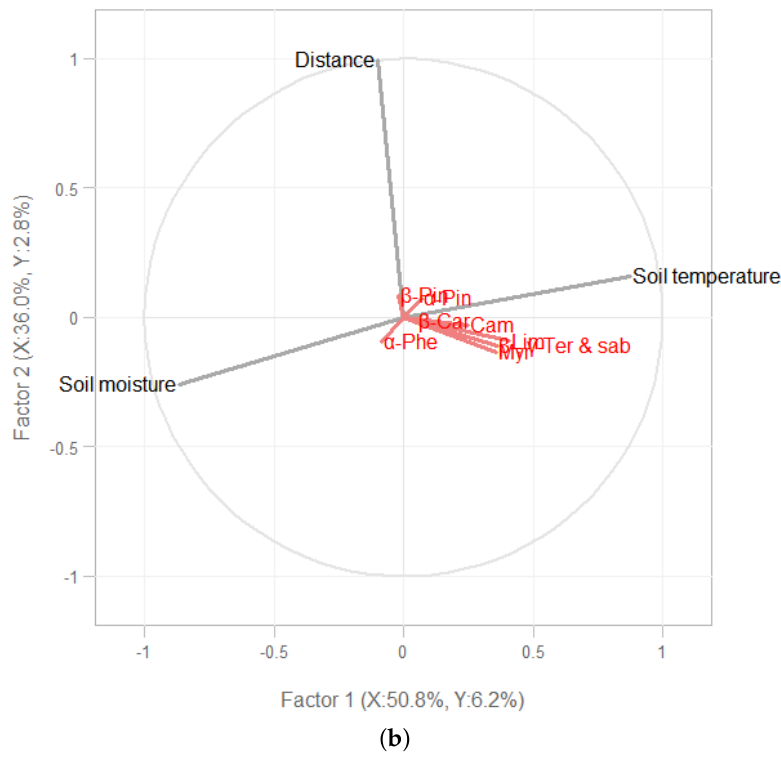
Figure 4. Relationship between total terpene emissions and litter dry weight within 4 m of the study trees ( a ). Partial least squares (PLS) regression between soil temperature or soil moisture content or distance to the trees and terpene exchange along the transects in turf zone ( ≥ 4 m) ( b ). Black represents soil temperature, soil moisture content and distance to the trees as independent variables (X), red represents exchange rates of individual terpenes as dependent variables (Y). α-Pin, α-pinene; Cam, camphene; β-Pin, β-pinene; Myr, myrcene; α-Phe, α-phellandrene; Lim, limonene; β-, γ-ter and sab, β-, γ-terpinene with sabinene; β-Car, β-caryophyllene.